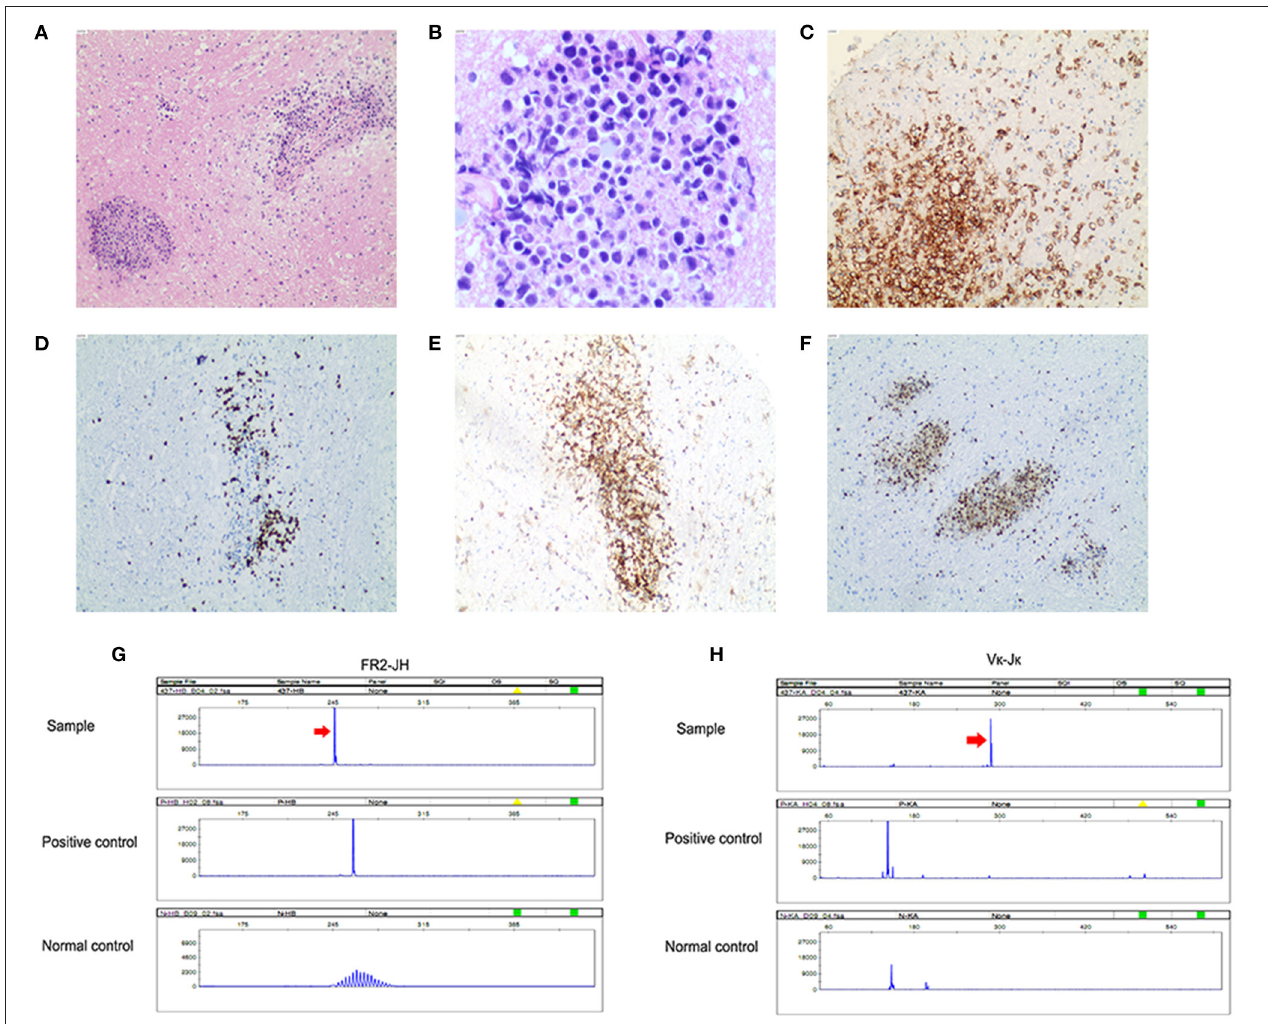
FIGURE 3 | Primary central nervous system lymphoma (diffuse large B-cell lymphoma). (A) Angiocentric pattern of distribution of atypical lymphoid cells (original magnification × 100); (B) Atypical lymphoid cells are large with irregular nuclei and scant cytoplasm (original magnification × 400); (C) Tumor cells are diffusely positive for CD20 (original magnification × 100) and (D) usually show a high Ki-67 proliferation index (original magnification × 100); (E) Tumor cells are positive for BCL 2 (original magnification × 100); (F) Tumor cells are positive for MUM-1 (original magnification × 100). PCR analysis of B-cell monoclonal immunoglobulin heavy